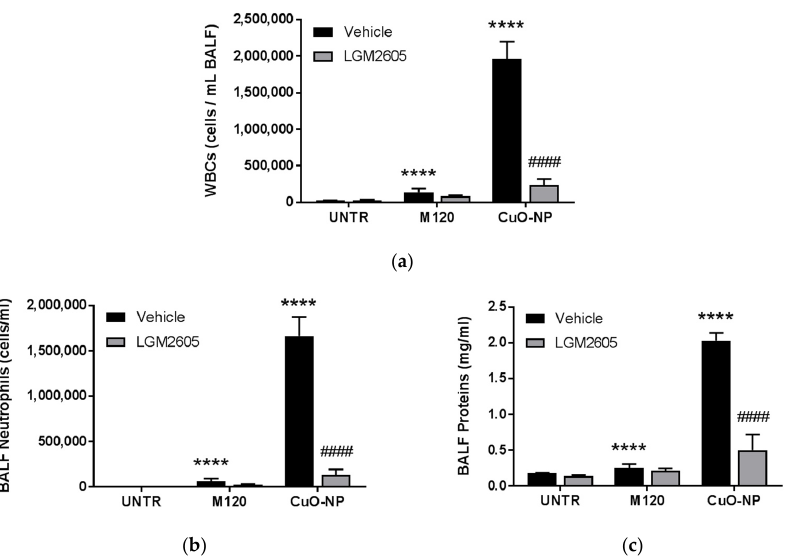
Figure 4. Prevention of CuO-NP-induced Acute Lung Injury in Mice by LGM2605. ( a ) BALF WBCs; ( b ) BALF PMNs; ( c ) BALF protein levels determined at 24 h following instillation of inert carbon control (M120) or 15 µg CuO-NPs. All data are presented as the mean ± the standard error of the mean ( n = 2–6 per treatment and exposure group). Asterisks indicate a statistically significant difference from their respective unexposed, control group (UNTR) (**** p < 0.0001) and # indicates a statistically significant difference from Vehicle (#### p < 0.0001). Levels of the proinflammatory cytokines, HMGB1 (Figure 5a), IL-1 β (Figure 5b), and TNF α (Figure 5c), followed a similar profile, where levels were significantly elevated among mice exposed to CuO-NP, but attenuated by the presence of LGM2605. Importantly, no statistically significant difference was observed among any of the exposure groups (UNTR, M120, and CuO-NP) for mice treated with LGM2605.